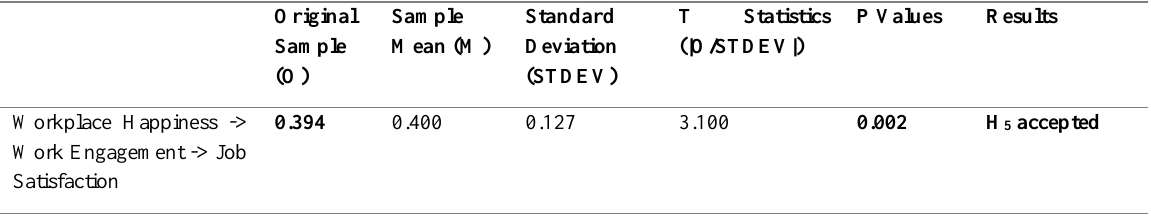
Table 9: Results of Specific Indirect Effect